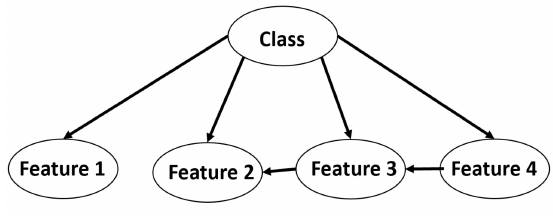
Figure 7. Bayesian network for input